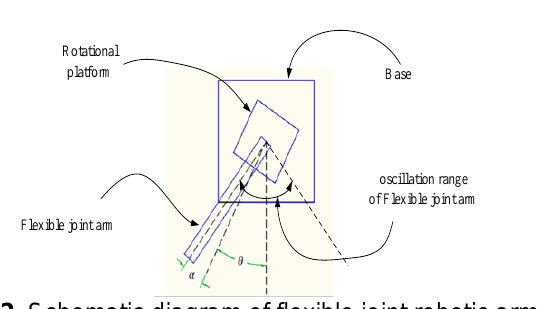
Fig 2. Schematic diagram of flexible joint robotic arm. Table 1. Parameters of flexible joint robot